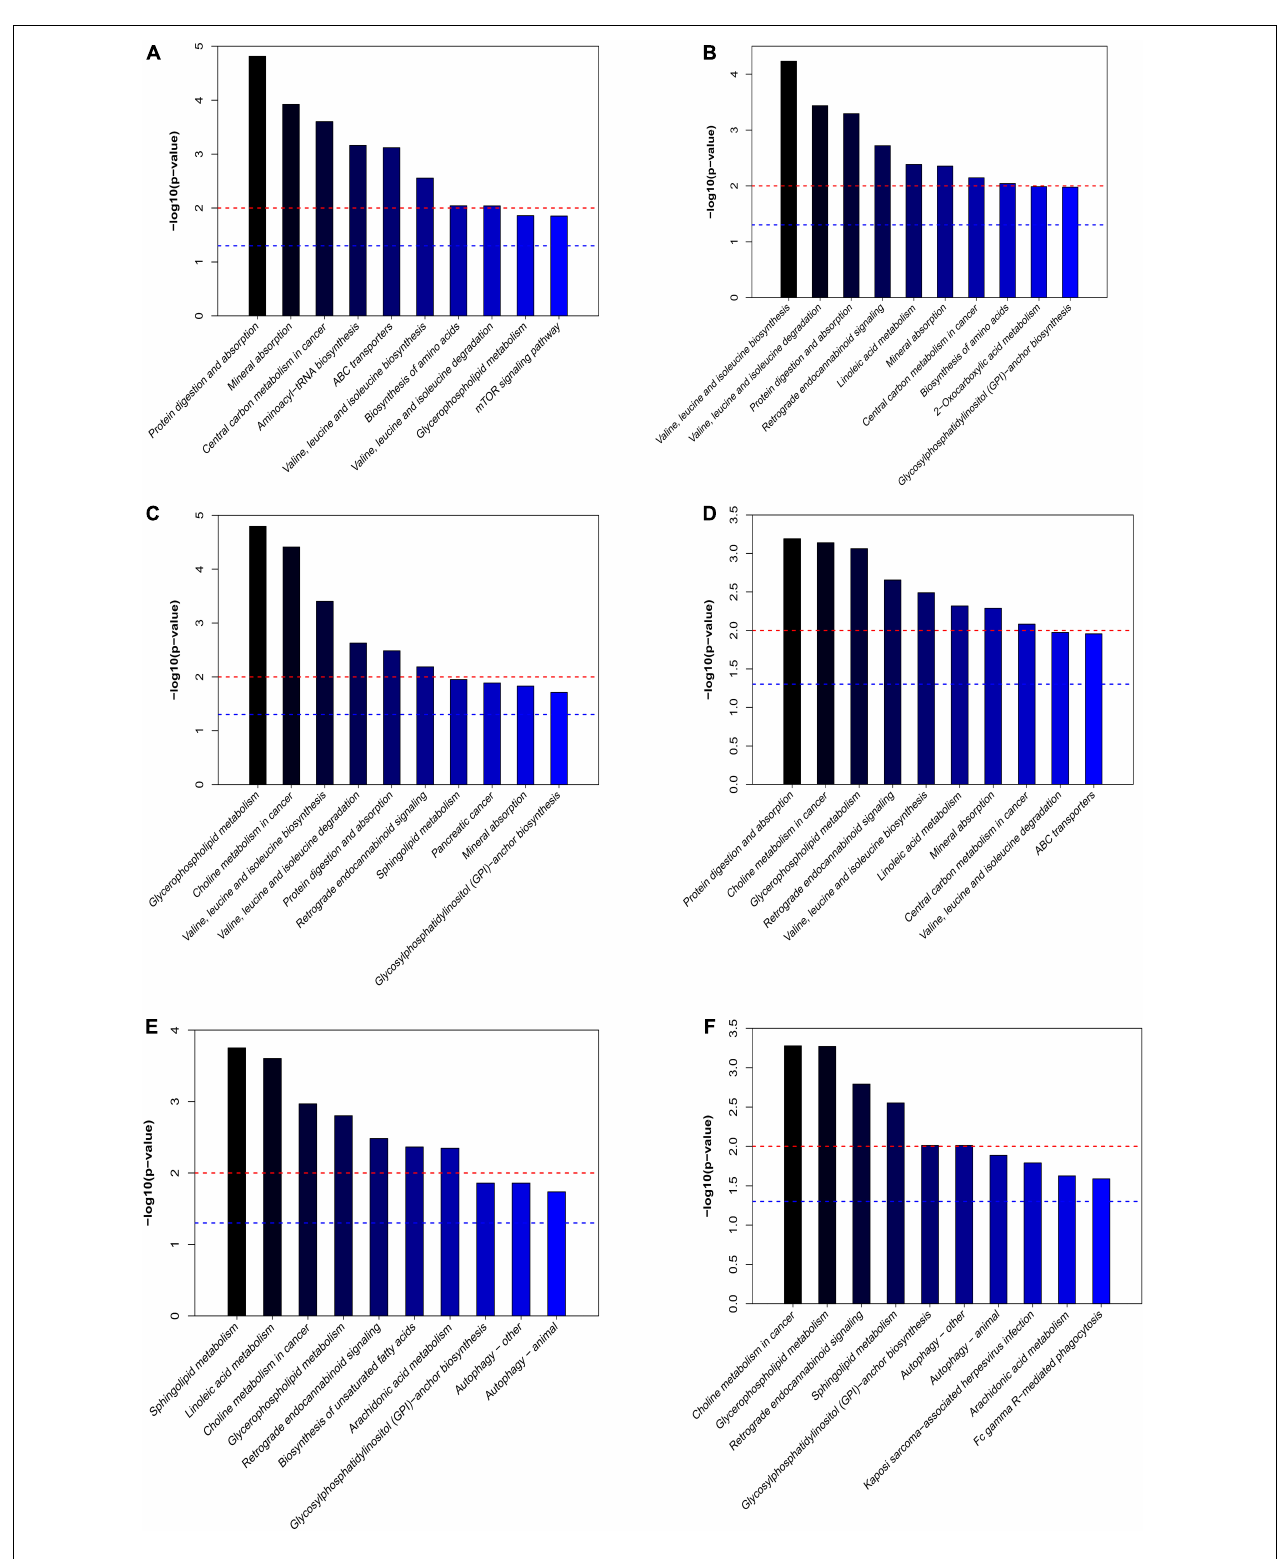
FIGURE 8 | The differentially expressed metabolic pathways among the PHx, AR113+PHx, PHx+AR113 groups of 3 or 7 days after PHx. (A) PHx and AR113+PHx groups of 3 days after PHx; (B) PHx and AR113+PHx groups of 7 days after PHx; (C) PHx and PHx+AR113 groups of 3 days after PHx; (D) PHx and PHx+AR113 groups of 7 days after PHx; (E) AR113+PHx and PHx+AR113 groups of 3 days after PHx; (F) AR113+PHx and PHx+AR113 groups of 7 days after PHx.